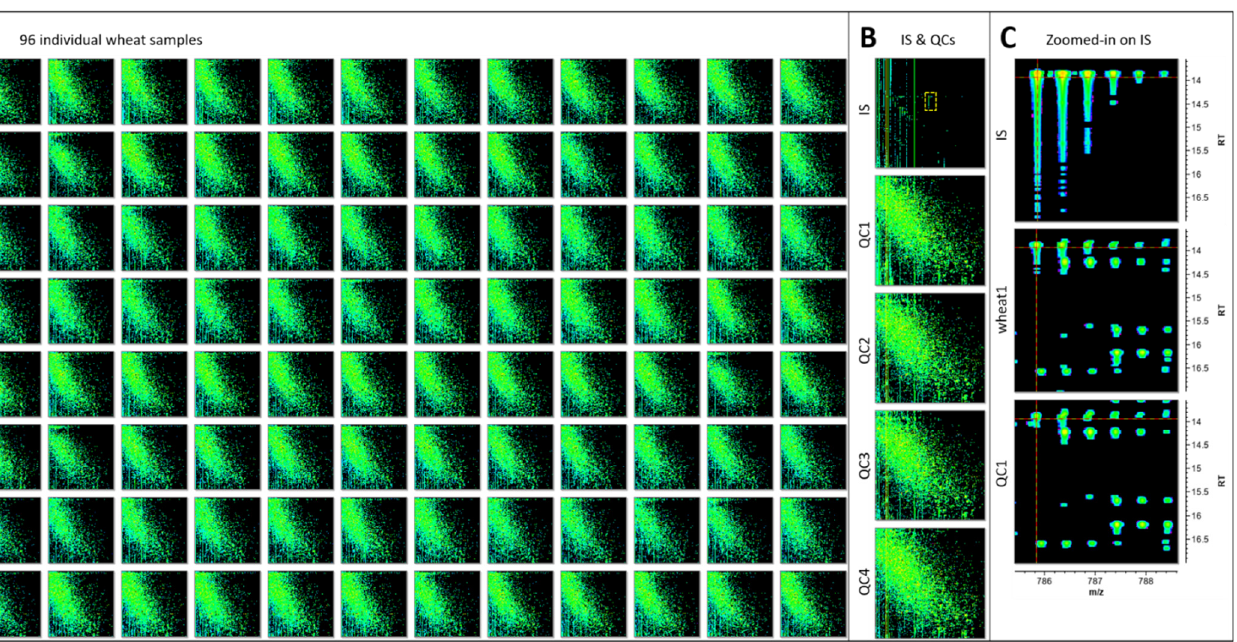
Figure 6. LC–MS maps for method validation. An amount of 20 mg (±0.2 mg) from 96 wheat cultivars was weighed, extracted using 0.5 mL Gnd-HCl buffer, and 10 µL extract aliquots were digested using trypsin/Lys-C. QCs and IS are described in the Materials and Methods. LC–MS data were acquired using LC method 6. ( A ) LC–MS maps of 96 individual wheat tryptic digests; ( B ) LC–MS maps of internal standard (IS) glu[1]-fibrinopeptide B and quality control samples (QCs), boxed section is where IS resolves and is zoomed-in in panel C; ( C ) zoomed-in section of LC–MS maps at 14–17 min and 785–789 m / z of the whole IS cluster on its own, in a wheat sample and in the QC sample; crossed dotted red lines pinpoint the 1 st isotopic LC–MS peak of IS.